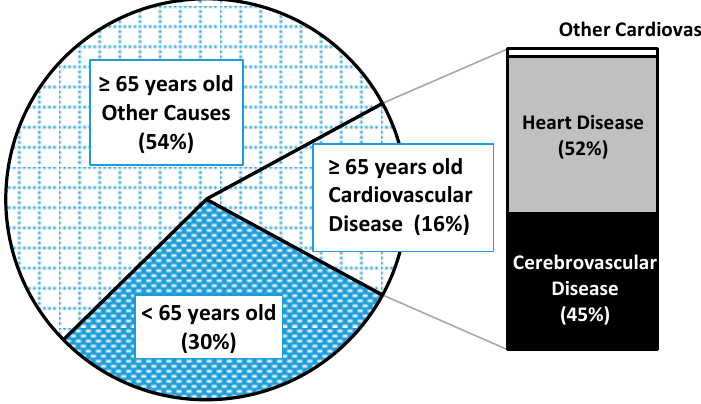
Figure 6. Specific causes of the mortality rate in Seoul from 2008 to 2018.